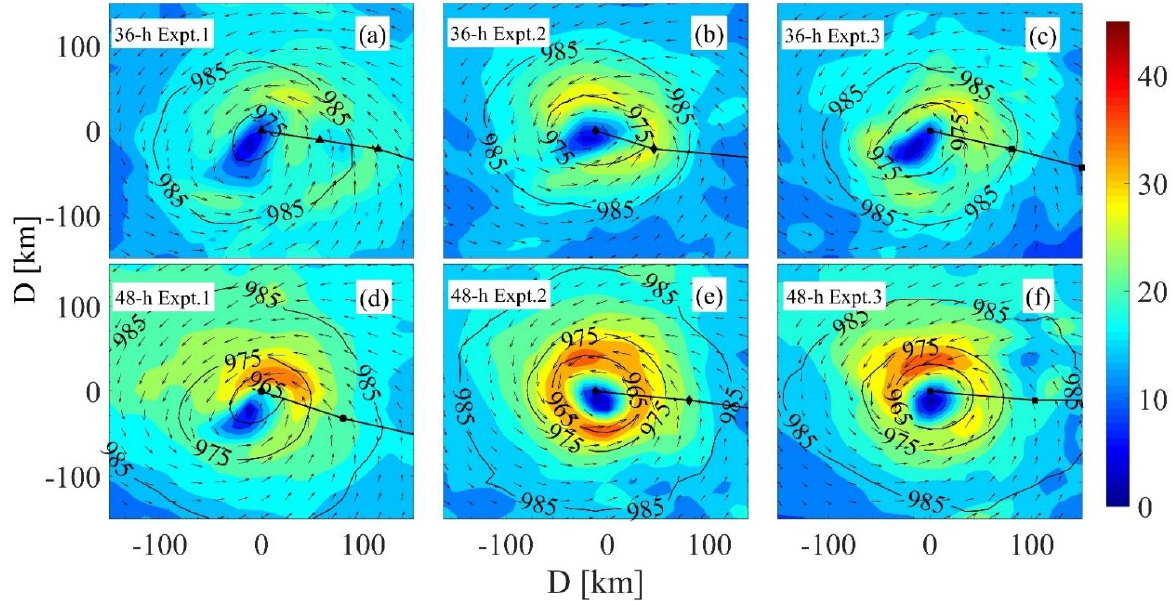
Figure 6. ( a – c ) The spatial distributions of wind speed (WSP) (shadowing at the interval of 10 m s − 1 ), local wind direction (vector), and SLP (contouring at the interval of 10 hPa) with the 6 h TC tracks (black line with the triangle, diamond, and square sign) after 36 h simulation for Expt.1, Expt.2, and Expt.3, respectively. ( d – f ) same as ( a – c ), but for the simulation after 48 h